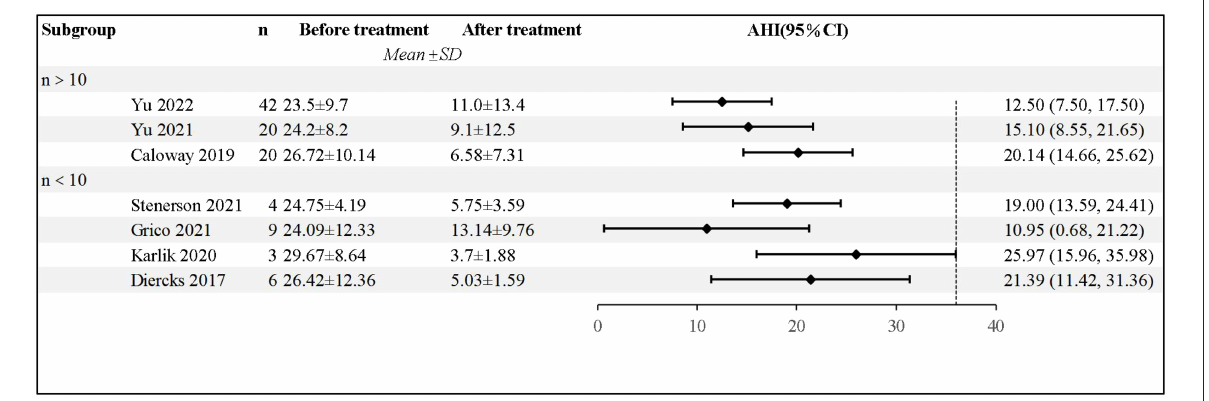
FIGURE2 The forest plot of studies investigating AHI.